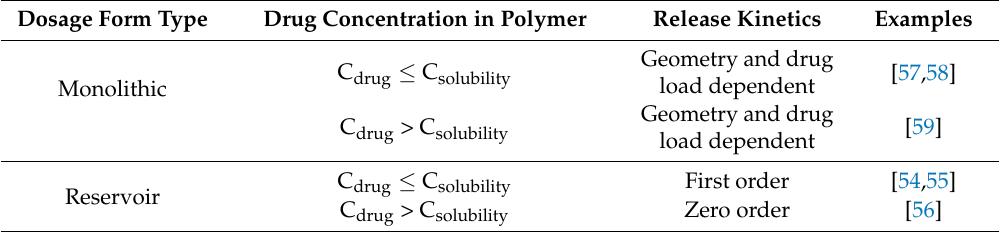
Table 1. Categories of Solute Diffusion from Polyurethane-based Sustained Release Dosage